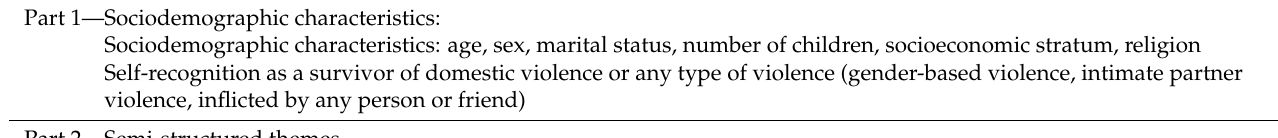
Table 1. Interview